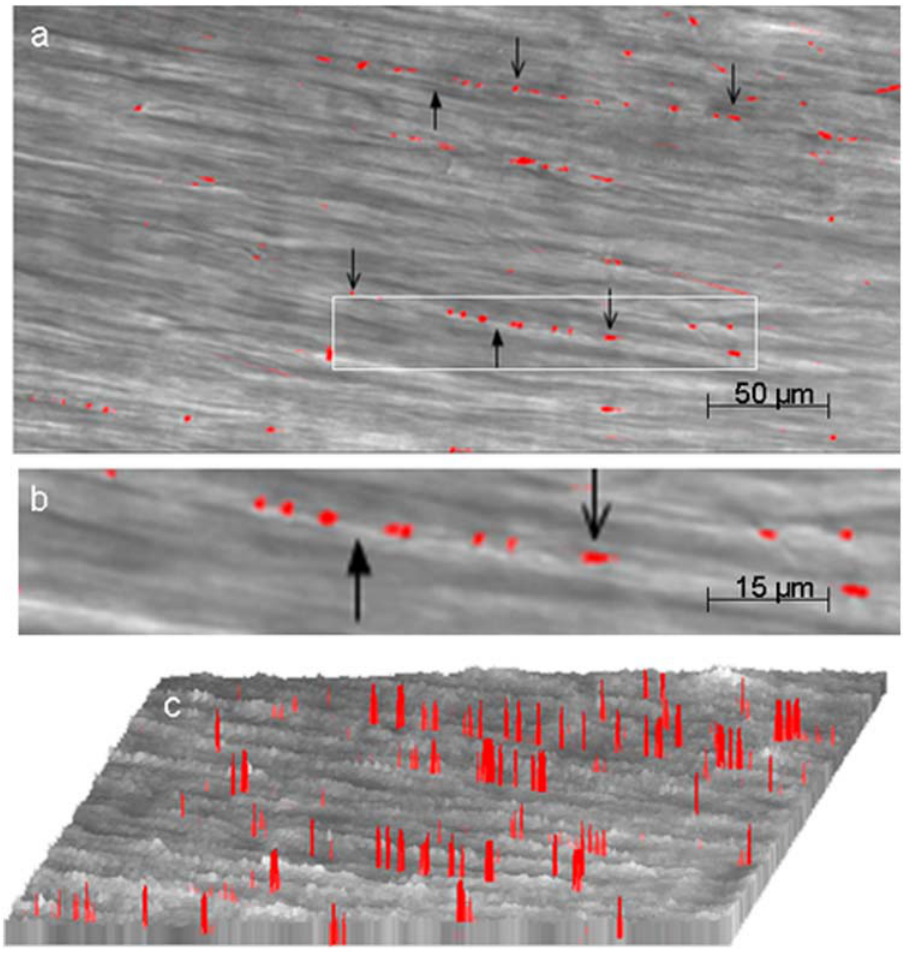
Figure 1. Visualization of myenteric nerve varicosities by their Ca 2 + signals. These studies were done after EFS of the muscle strips preloaded with the indicator calcium orange. The fluorescent image was superimposed on the image in the transmission mode (a) is a low power view fluorescent (orange-red) varicosities. Note the varicosities along the axon running in the long axis of the circular muscles. (b) is magnified view of one of the axons with varicosities along its length . Downward pointing arrows show the varicosities and upward pointing arrows indicate the inter- varicosity axon. (c) shows intensity profiles of the fluorescent varicosities. Note that there was no Ca + signal in smooth muscle cells.